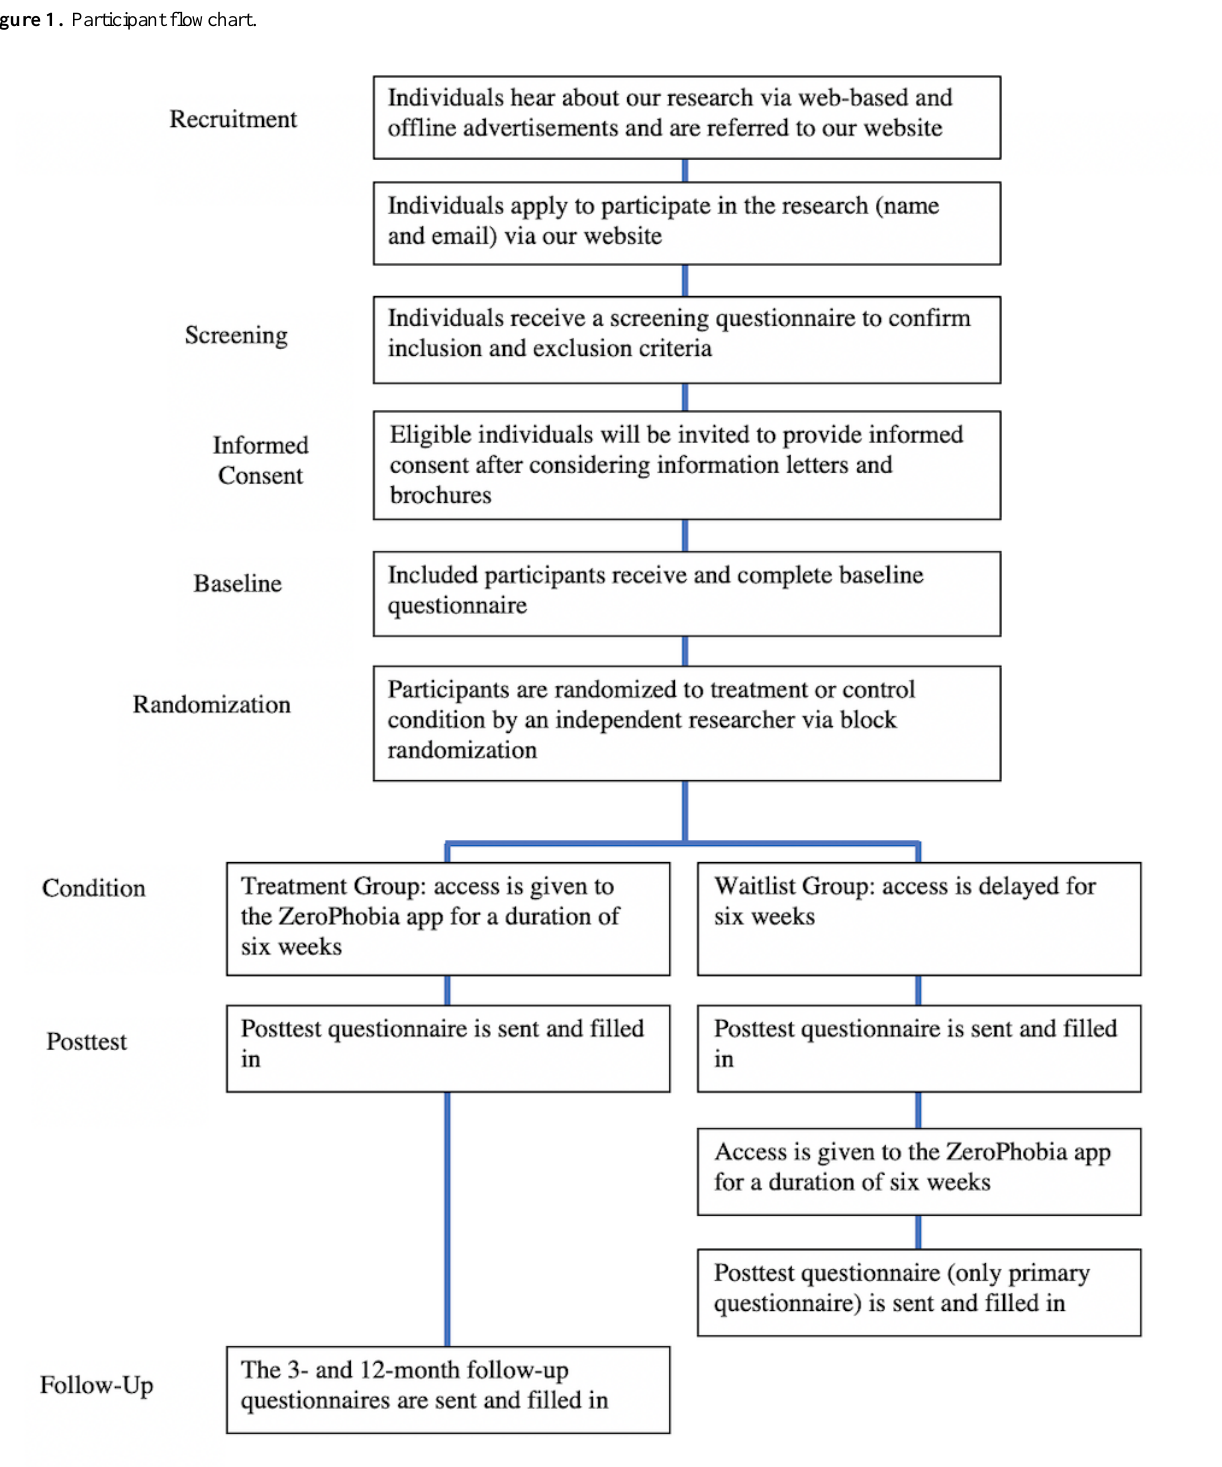
Figure 1. Participant